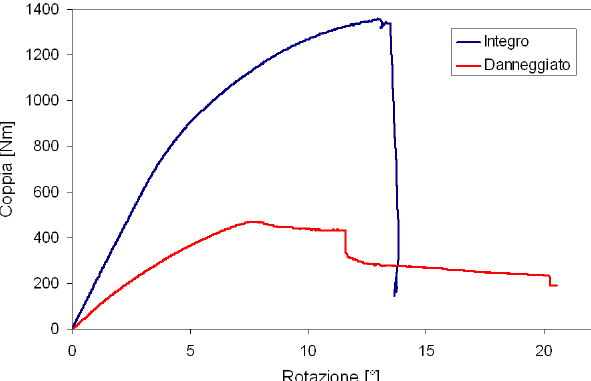
Figura 14: Confronto fra le curve coppia-rotazione ottenute dalle prove effettuate su un provino integro e su un provino con danneggiamento balistico